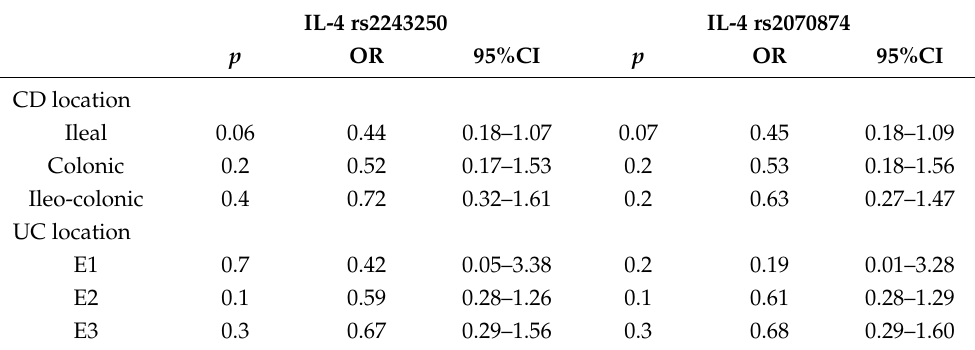
Table 5. Results for allele frequency differences in IBD patients versus healthy controls depending on disease location.